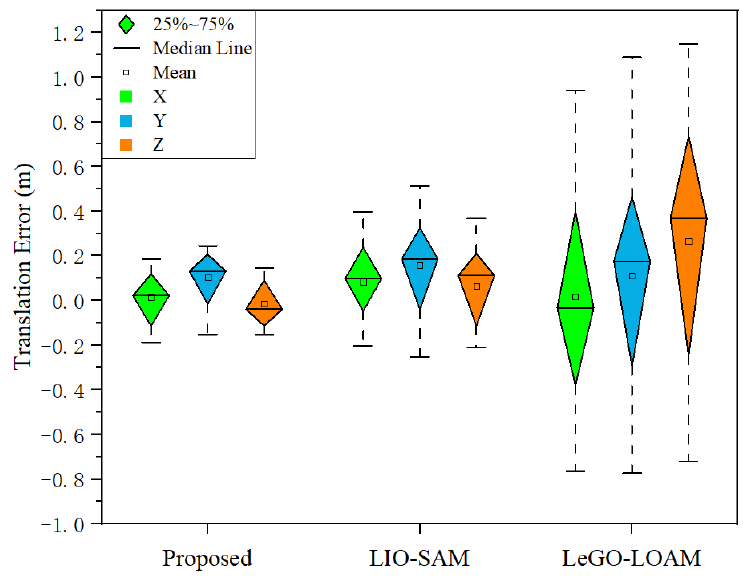
Figure 11. Absolute localization errors.